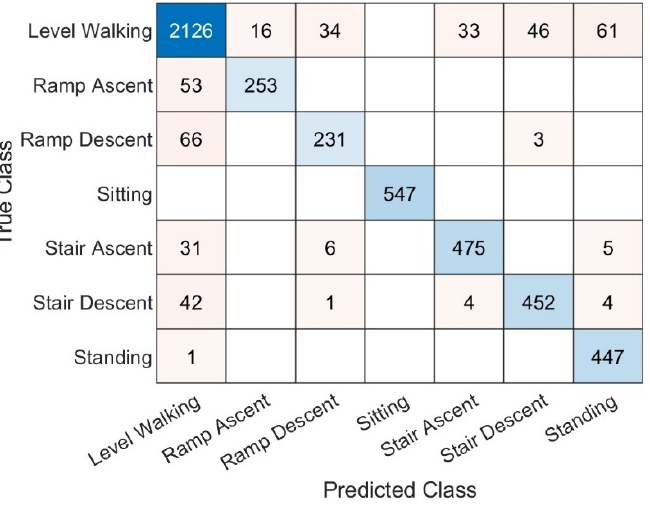
Figure 5. Combined confusion matrix for classification with sonomyography data alone. Correct classifications are shaded in blue, while incorrect classifications are shaded in pink. The depth of shading corresponds to the number of observations in each cell of the matrix as a proportion of the total number of observations.